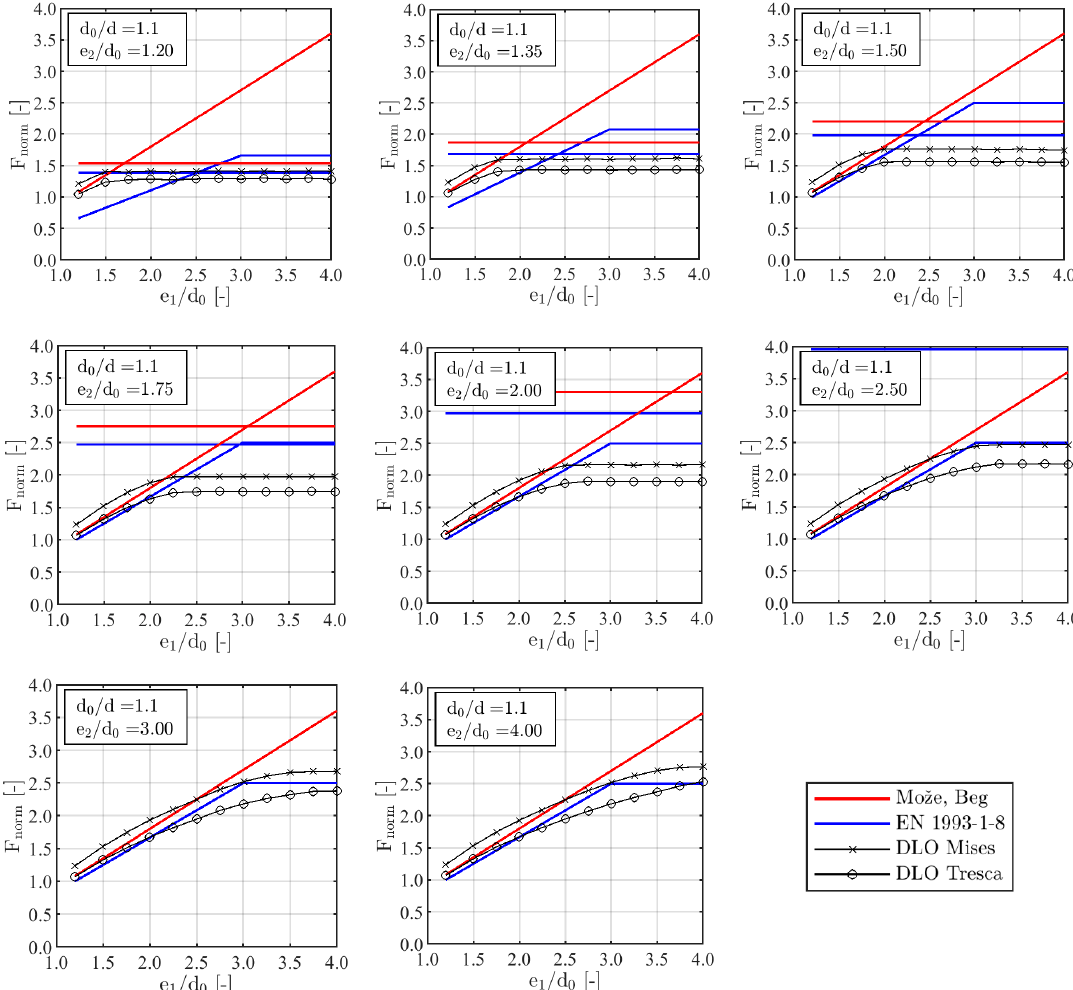
Figure 20. Comparison of normalized loads for d 0 /d = .